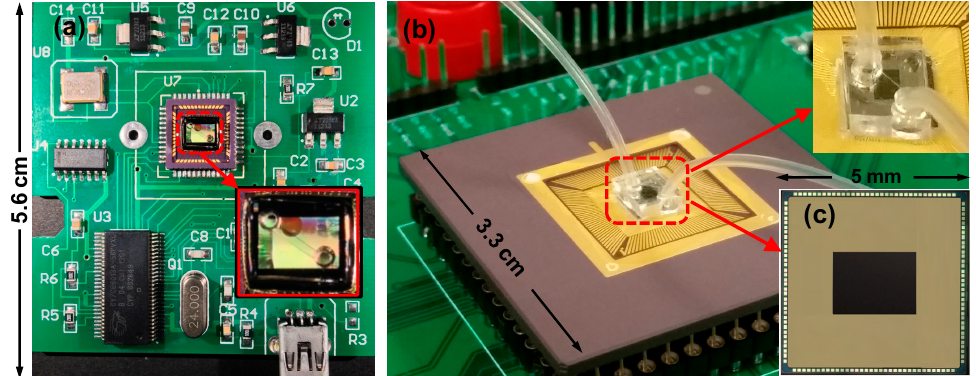
Figure 3. Testing board for lensless blood cell imaging. ( a ) lensless system using commercial FSI CIS; ( b ) packaged BSI CIS integrated with the microfluidic channel and elastic thin tubing; and ( c ) custom designed BSI CIS chip.